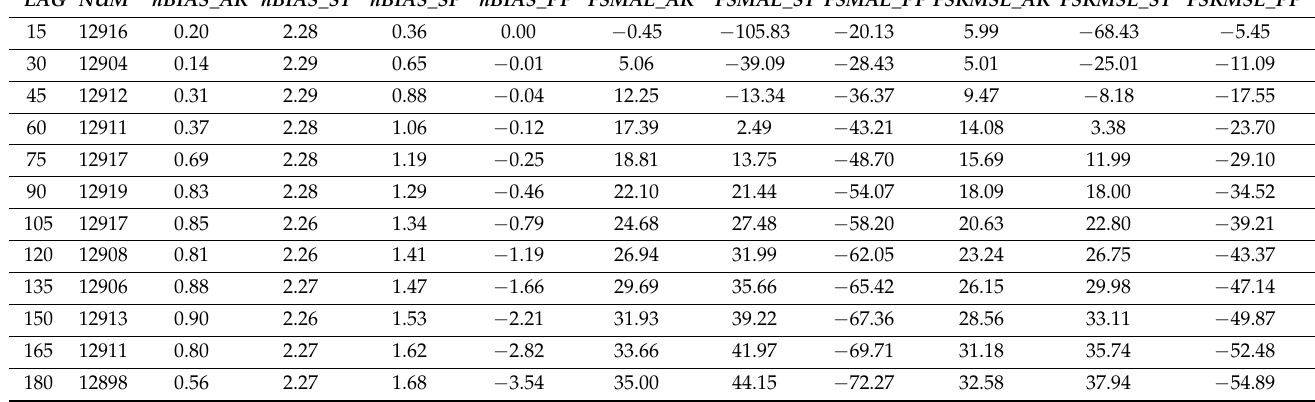
Table 6. Normalized BIAS and forecast skill related to MAE–FSMAE and RMSE–FSRMSE for plant P2 from 15 min up to three hours